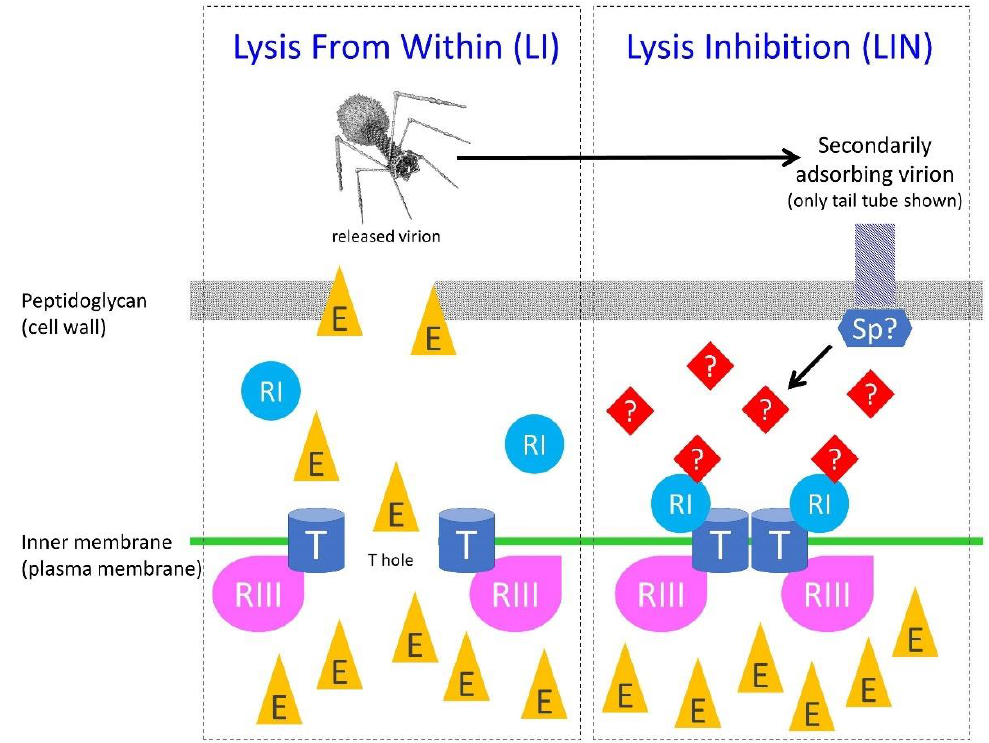
Figure 7. T-hole formation and its inhibition: lysis from within (LI; left) versus lysis inhibition (LIN; right). LI is caused by plasma membrane disruption as mediated by the phage T-holin protein and resulting T holes. With secondary adsorption, T-hole formation can be blocked. This occurs due to